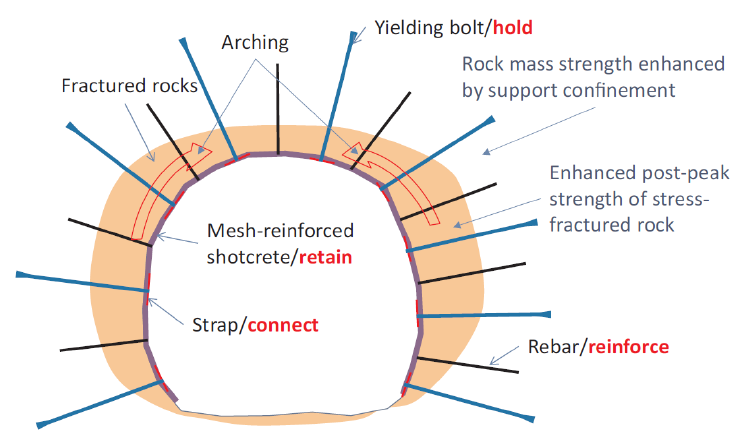
Figure 12. Required support functions in burst-prone ground (from [192]).